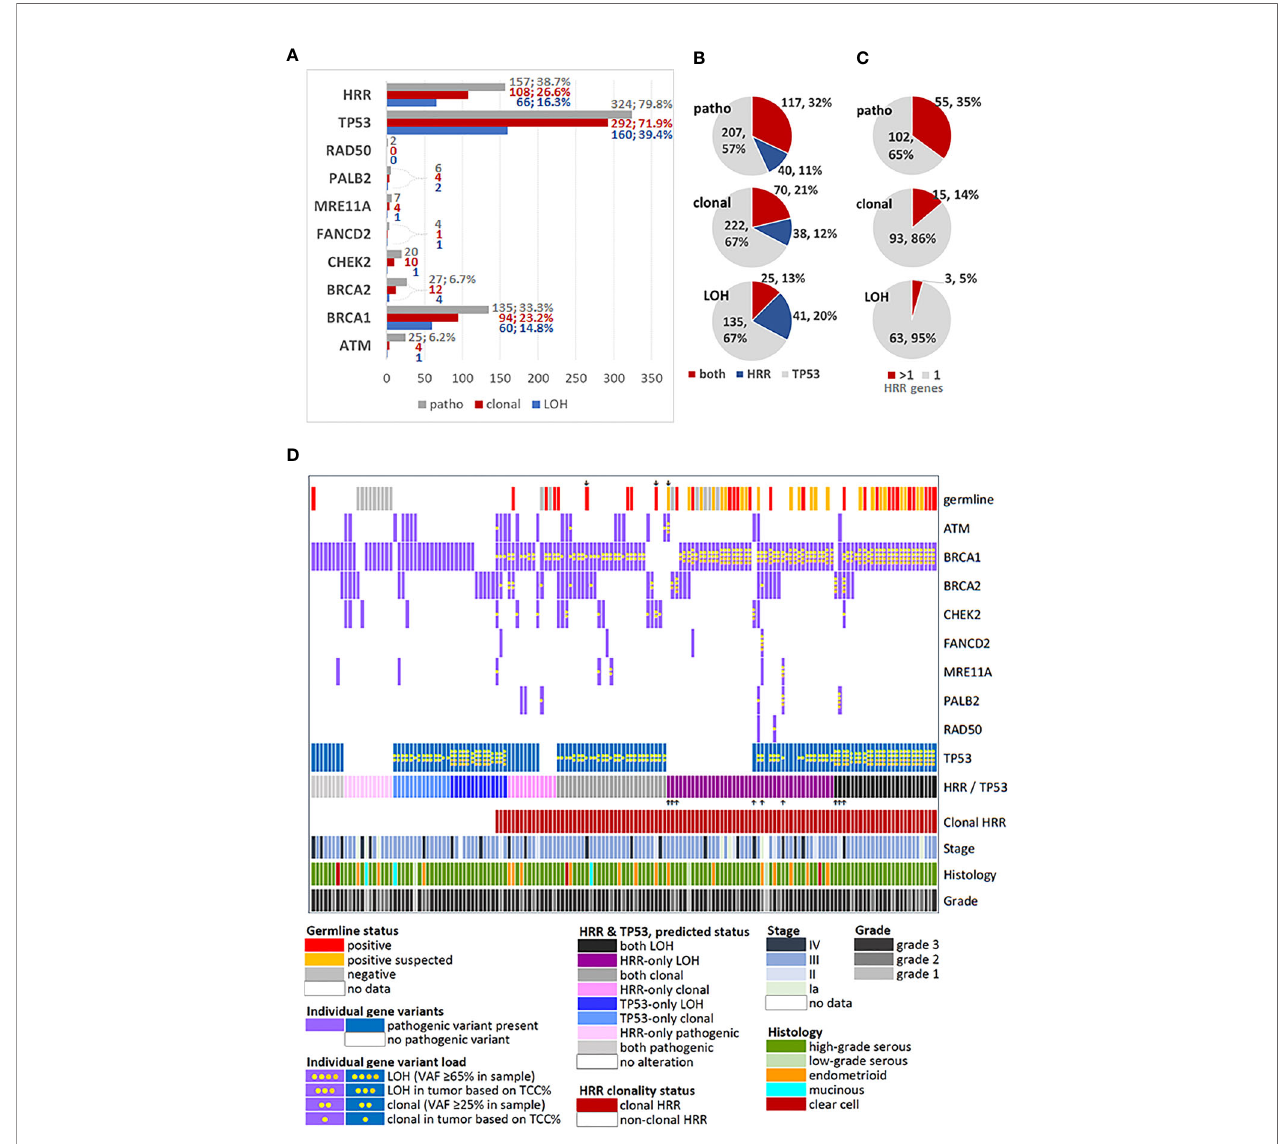
FIGURE 1 | Description and distribution of alterations in HRR and TP53 genes. (A) Incidence of alterations for each studied gene and for grouped HRR genes. Variants were classi fi ed as pathogenic, by simple presence, and as clonal or position-LOH, based on mutation and tumor DNA load in the examined sample. X-axis: number of affected tumors. Percentages are shown for rates >5% among all tumors with pathogenic variants (n=406). (B) Distribution of TP53/HRR gene co- mutations in the same tumor, among tumors bearing the same class of alteration in any of these genes. (C) Distribution of multiple HRR gene pathogenic variants in the same tumor, among tumors bearing the same class of alteration in these genes. (D) Map showing pro fi led HRR and TP53 gene mutations among tumors bearing any class of alterations in these genes, in comparison to germline mutation status and standard clinicopathological parameters. Up or down showing arrows: non-BRCA1 alterations. Tumors with only TP53 mutations and non-mutated tumors were not included in this